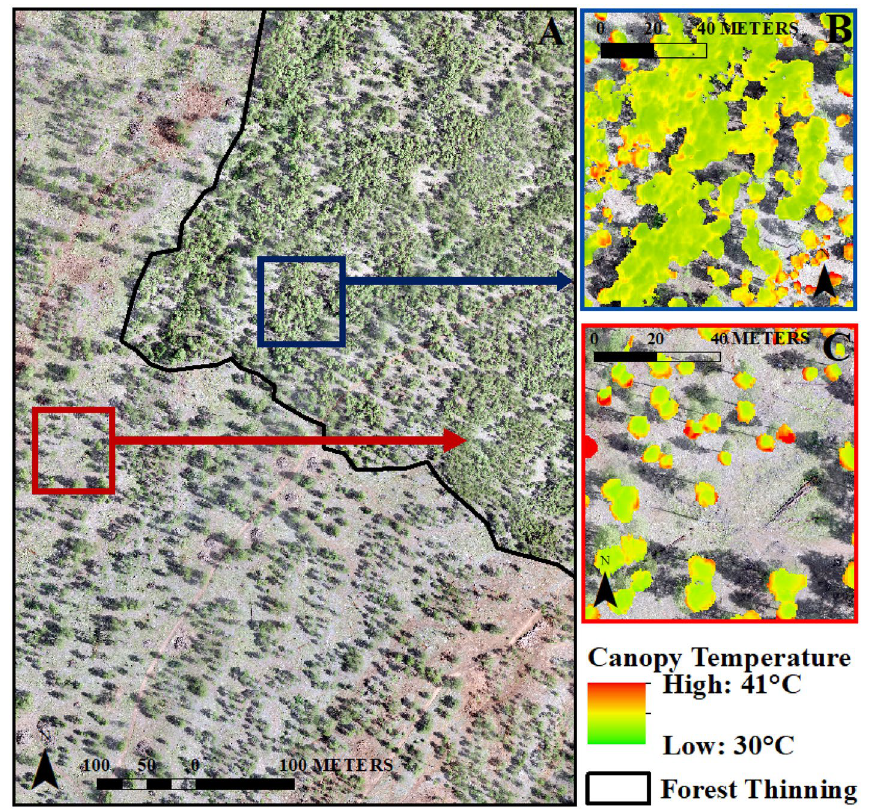
Figure 3. UAV image across a forest thinning boundary at the study area (panel A ) and UAV thermal image- derived ponderosa pine forest canopy temperature examples from non-thinned (panel B ) and thinned (panel C ) forests in northern Arizona during drought year